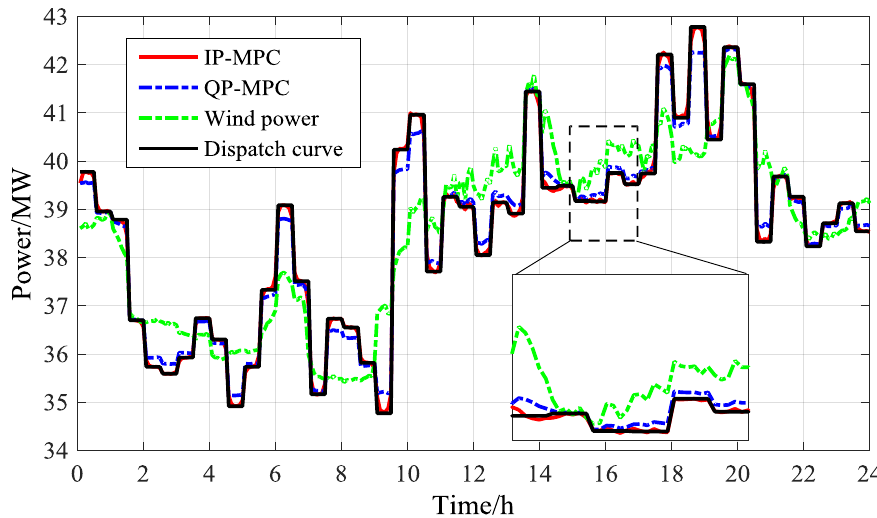
Figure 9. Wind power and dispatch power (9 MWh).